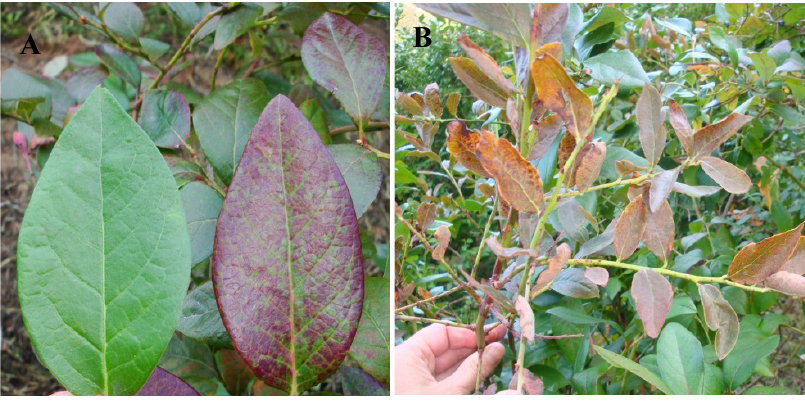
Figure 9. Symptoms of blueberry bronze leaf curl disease: A. Leaf exhibiting mid season reddening, healthy leaf on left, symptomatic leaf on the right; B. General bronzing with some upward curling of leaves (Photos Courtesy Annemiek Schilder, Michigan State